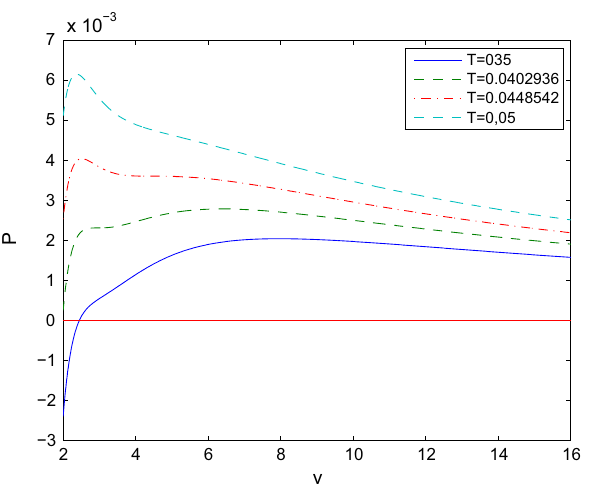
Fig. 8 The plot of the critical pressure P c vs β at q m = 1